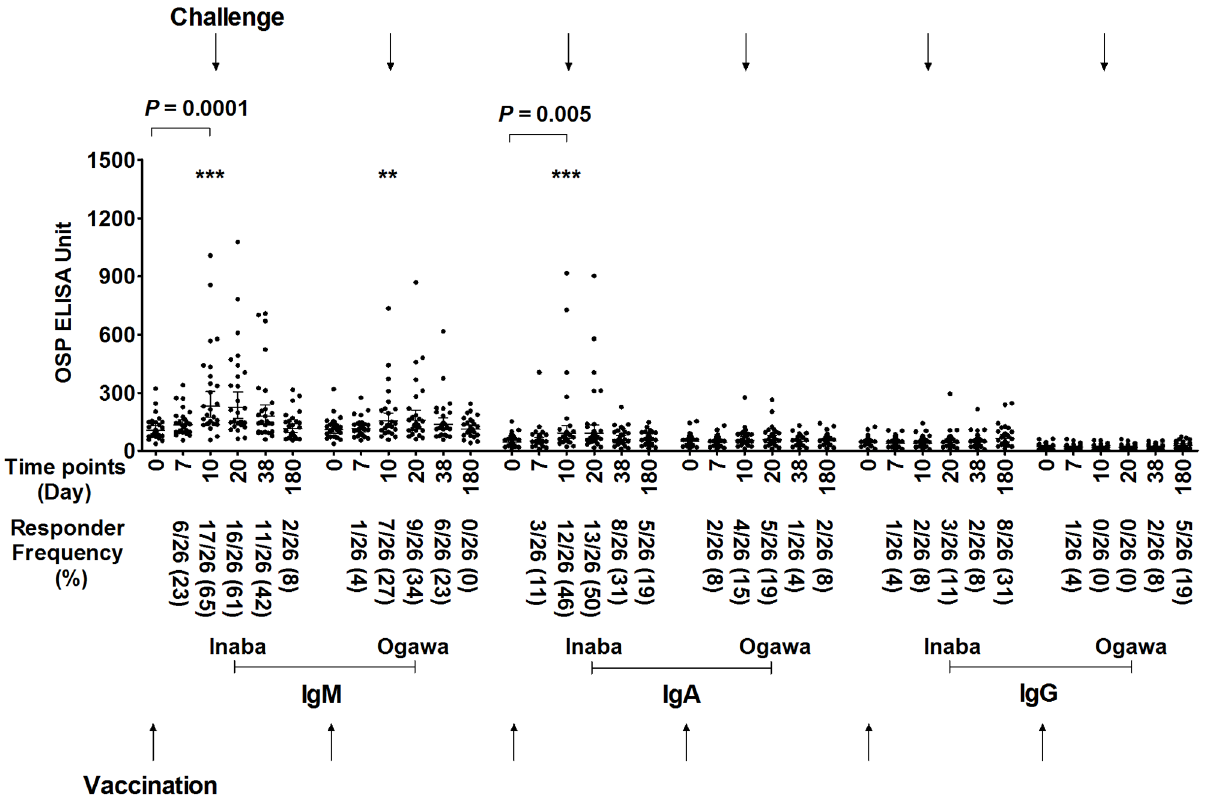
Fig 2. Serum antibody responses against OSP in vaccinees of day 10 challenged group. Serum IgM, IgA and IgG responses targeting V . cholerae O1 Inaba or Ogawa OSP in recipients (n = 26) of oral cholera vaccine CVD 103-HgR who were then experimentally challenged with wild type V . cholerae O1 Inaba N16961 10 days after vaccination (denoted by top arrows). Day 0 is pre-vaccination and other dates are timed from vaccination. X axis indicates the time points of samples, while Y-axis denotes OSP-specific antibody responses. Each single dot indicates an individual OSP antibody value, horizontal bars indicate the geometric mean (GM), and error bars indicate 95% confidence intervals. P values represent differences of the mean between groups. Asterisks represent significant differences in responder frequency in Fisher’s exact test ( (cid:3)(cid:3)(cid:3) P (cid:20) 0.001, (cid:3)(cid:3) P (cid:20) 0.01). We defined a responder as having a (cid:21) 1.5-fold increase in anti-OSP units compared to pre-vaccination value. Responder frequency is represented in parenthesis on x-